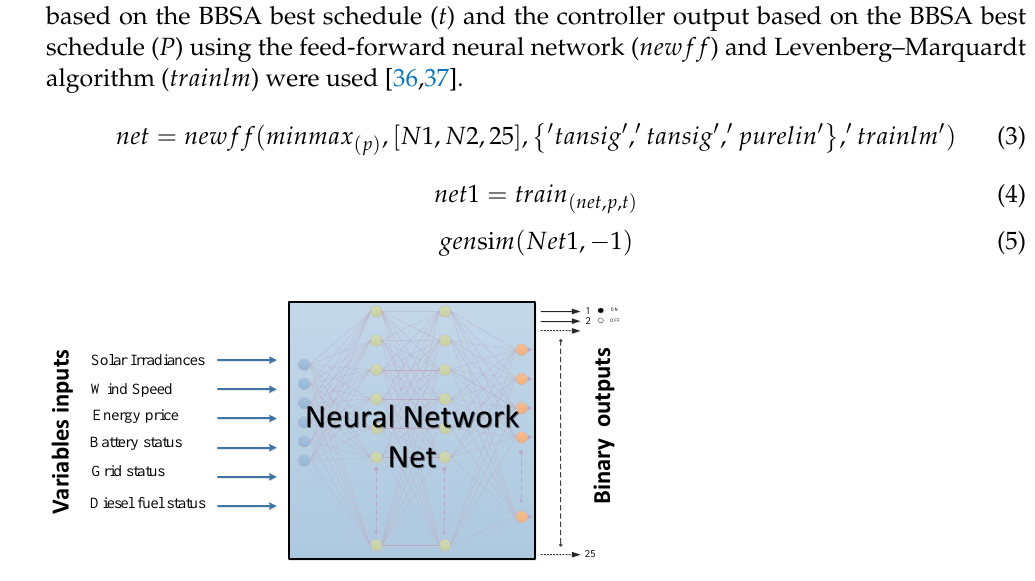
Figure 4. Block diagram of neural network net schedule controller.